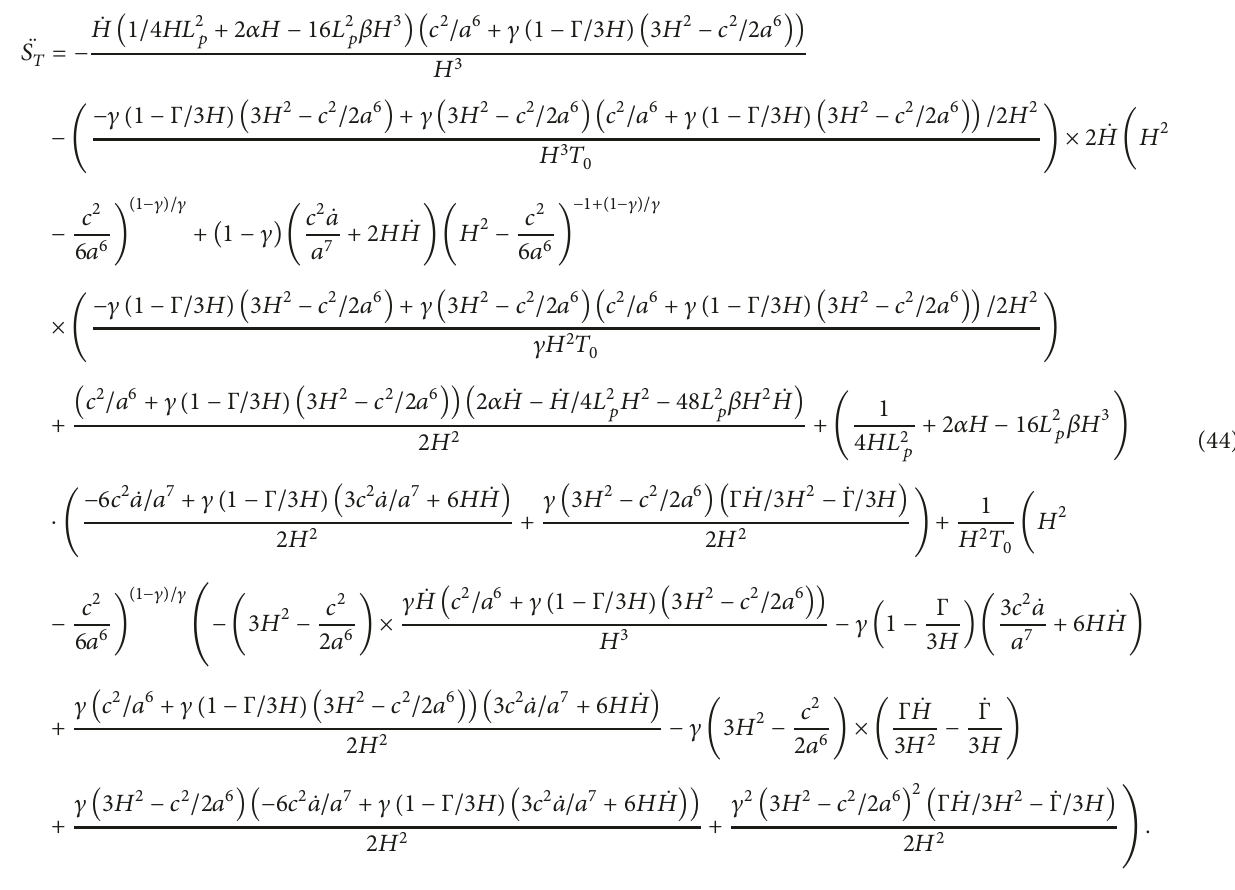
̈𝑆 𝛾 for three values of 𝑇 is shown in The plot of 𝑇 versus Figure 9 by keeping the constant values same as for constant Γ . It is observed that the thermodynamical is obeying the ̈𝑆 < 0 which leads to the validity of thermody- condition 𝑇 namical equilibrium.